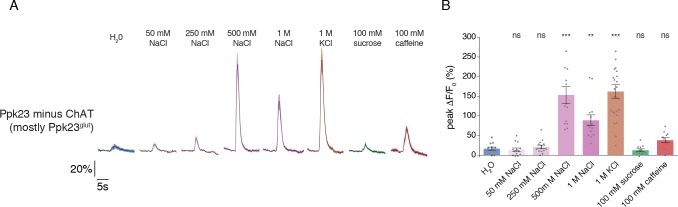
Ppk23glut GRNs respond to high salt.(A) GCaMP6f expression was primarily restricted to Ppk23glut GRNs using Ppk23-Gal4 in combination with ChAT-Gal80. Lines and shaded regions represent mean ±SEM of responses over time, with stimulation occurring at 5 s. (B) Peak fluorescence changes during each stimulation. Bars represent mean ±SEM, n = 17. Asterisks indicate significant difference from water by one-way ANOVA with Bonferroni post hoc test, *p<0.05, **p<0.01, ***p<0.001.